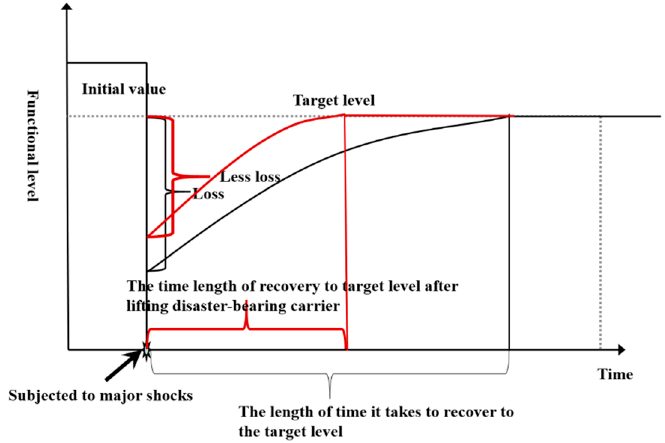
Figure 3. Contrast chart of different disaster-bearing vehicles on the city safety resilience curve.